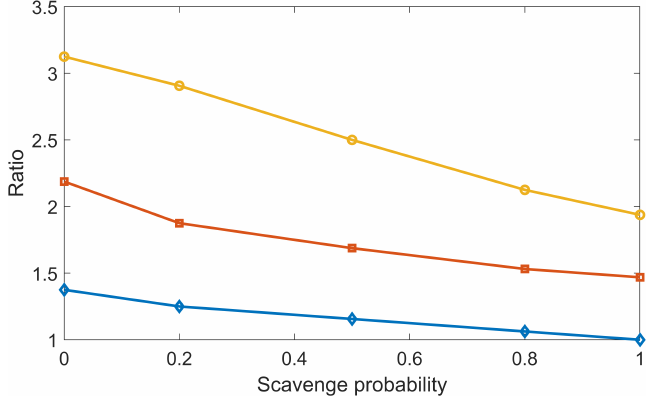
Figure 8. Ratio of DSB yields with different scavenge probabilities.